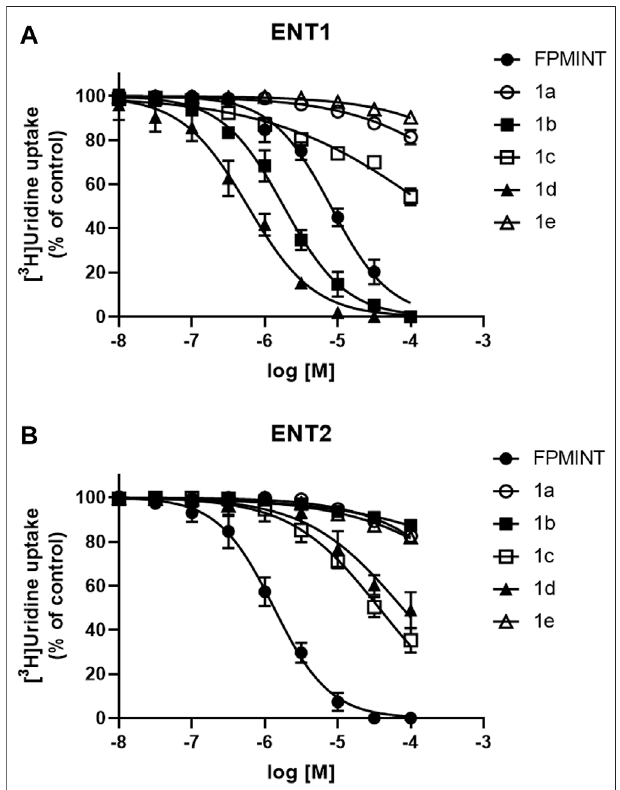
FIGURE 2 | Effects of FPMINT analogues (listed in Supplementary Table S1 ) on [ 3 H]uridine uptake by ENT1 and ENT2 [ 3 H]uridine uptake (1 μ M,